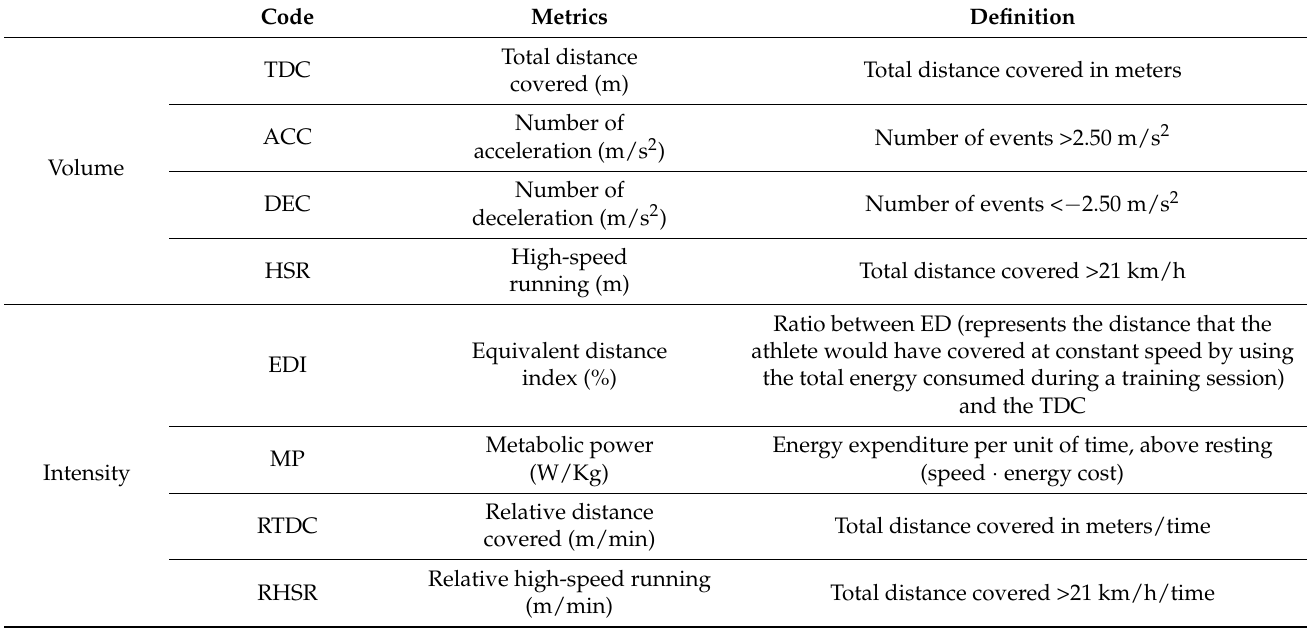
Table 1. Volume and intensity metrics